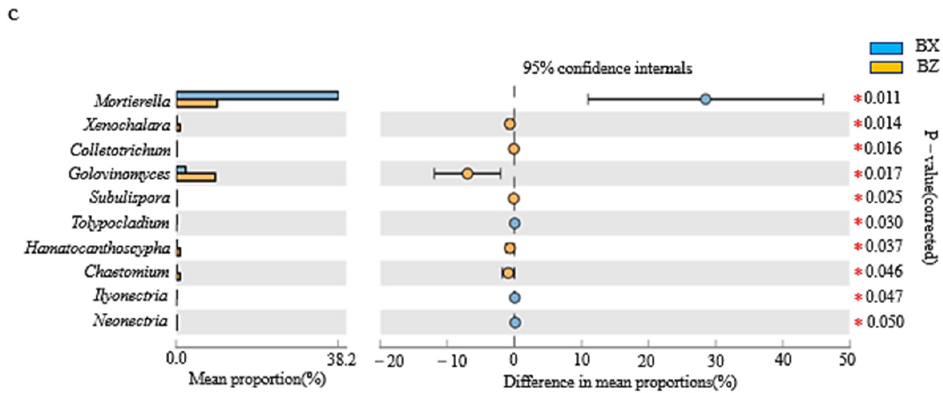
Figure 7. Di ff erential analysis of horizontal fungus abundance in litter. Di ff erence of fungal abundance between ( a ) litter layers of plantation forest and original Korean pine forests, ( b ) middle layer and lower litter layers in Korean pine plantation forest, and ( c ) middle and lower litter layers in original Korean pine forest. *, significant di ff erence between the two groups of data ( n = 3, p < 0.05); **, very significant di ff erence between the two groups of data ( n = 3, p < 0.01); ***, very significant di ff erence between the two groups ( n = 3, p < 0.001).